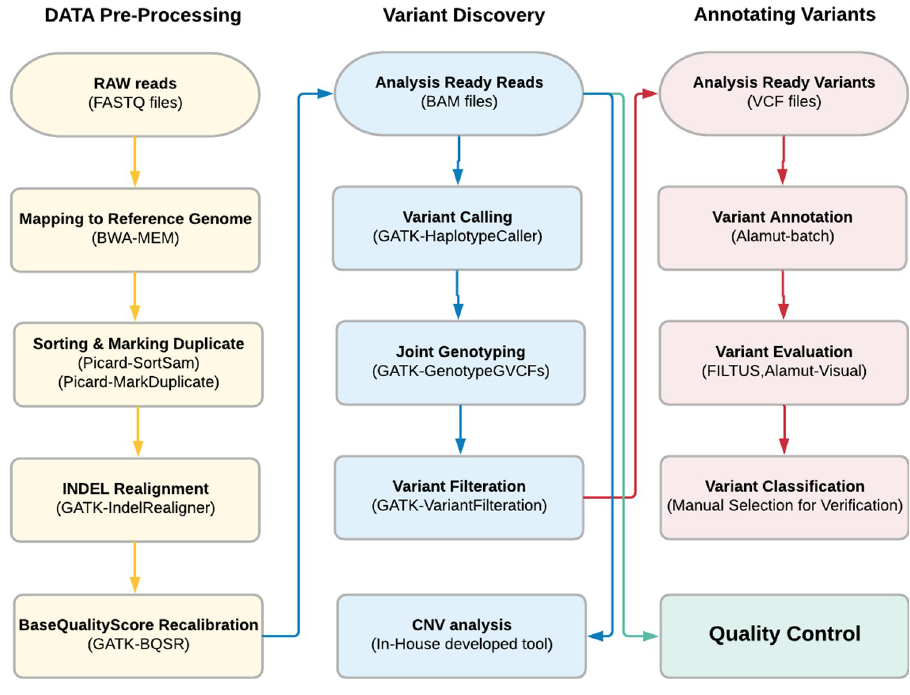
Fig 1. Schematic overview of the bioinformatics pipeline.